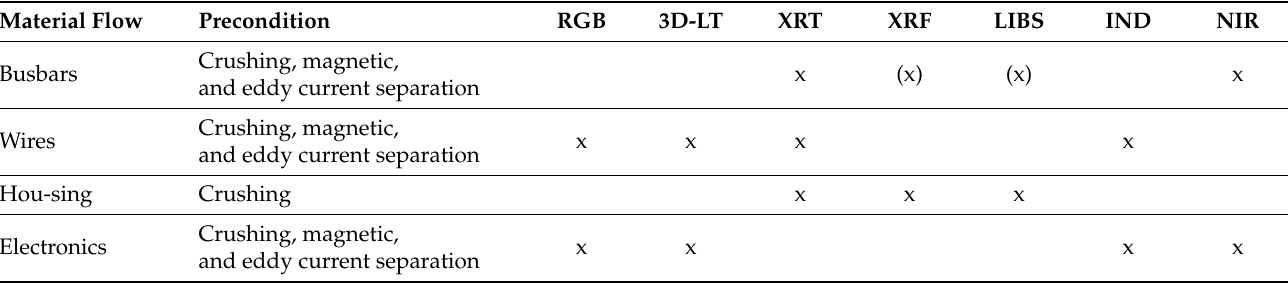
Table 2. Sensor-based sorting of periphery fractions from a battery pack.